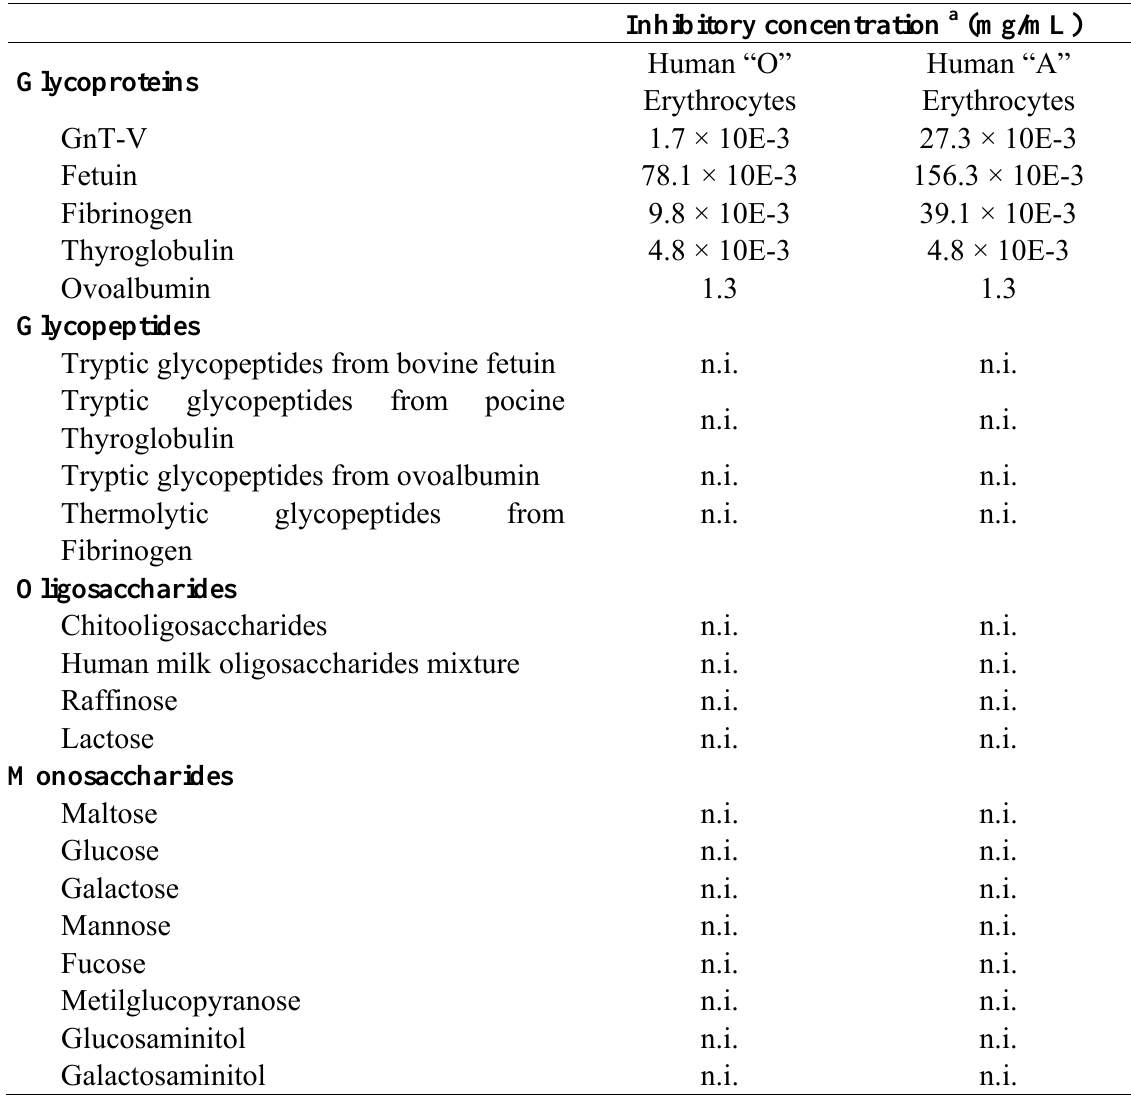
lectin from tepary